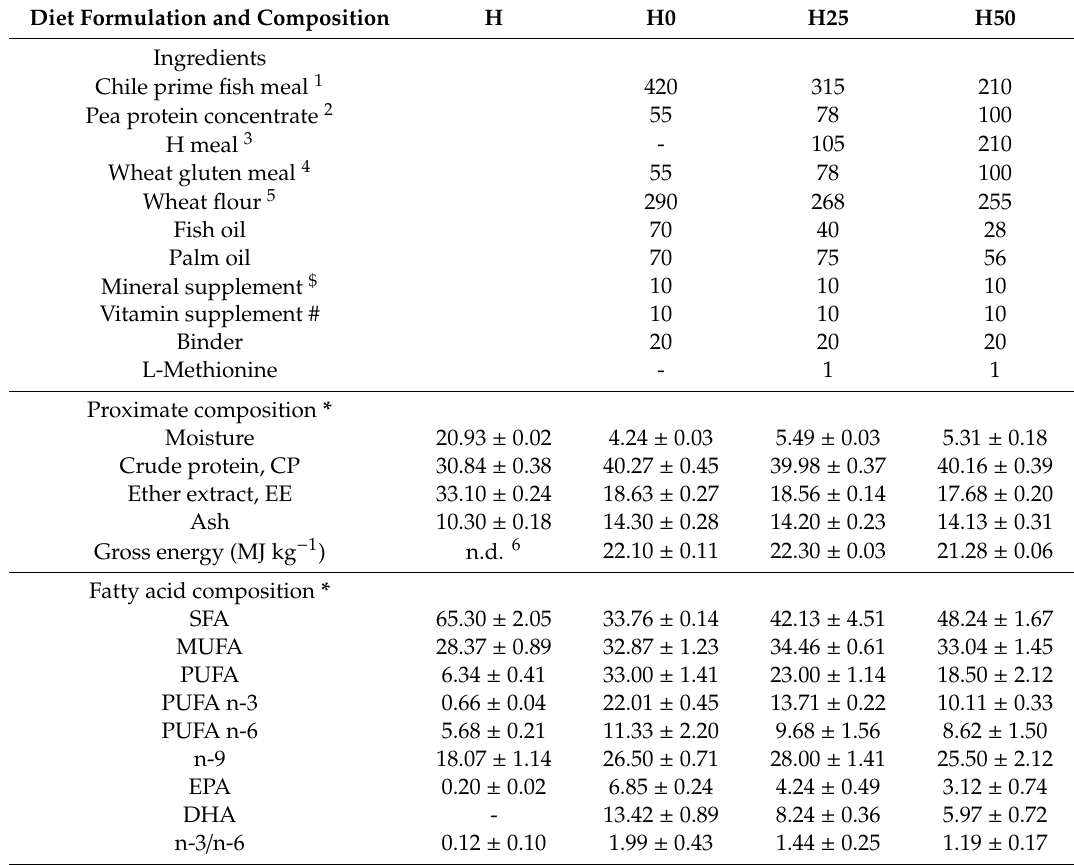
Table 1. Ingredients (g kg − 1 ), proximate composition (g 100 g − 1 ) and summary of the major fatty acid classes (as percentage of total FAMEs) of prepupae meal (H) and the experimental diets. H0, basal diet containing conventional ingredients; H25 and H50, experimental diets containing graded inclusion levels of H